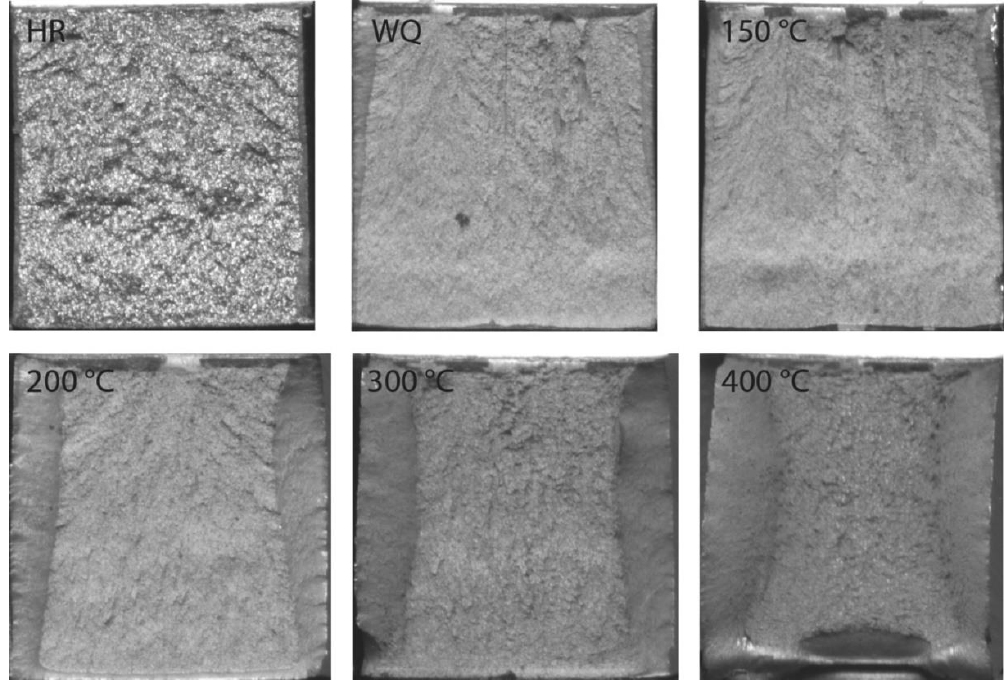
Figure 8. Macroscopic fracture surfaces of the Charpy-V samples (width 7.5 mm) tested at +20 °C. Notch is in the upper part of the specimens.